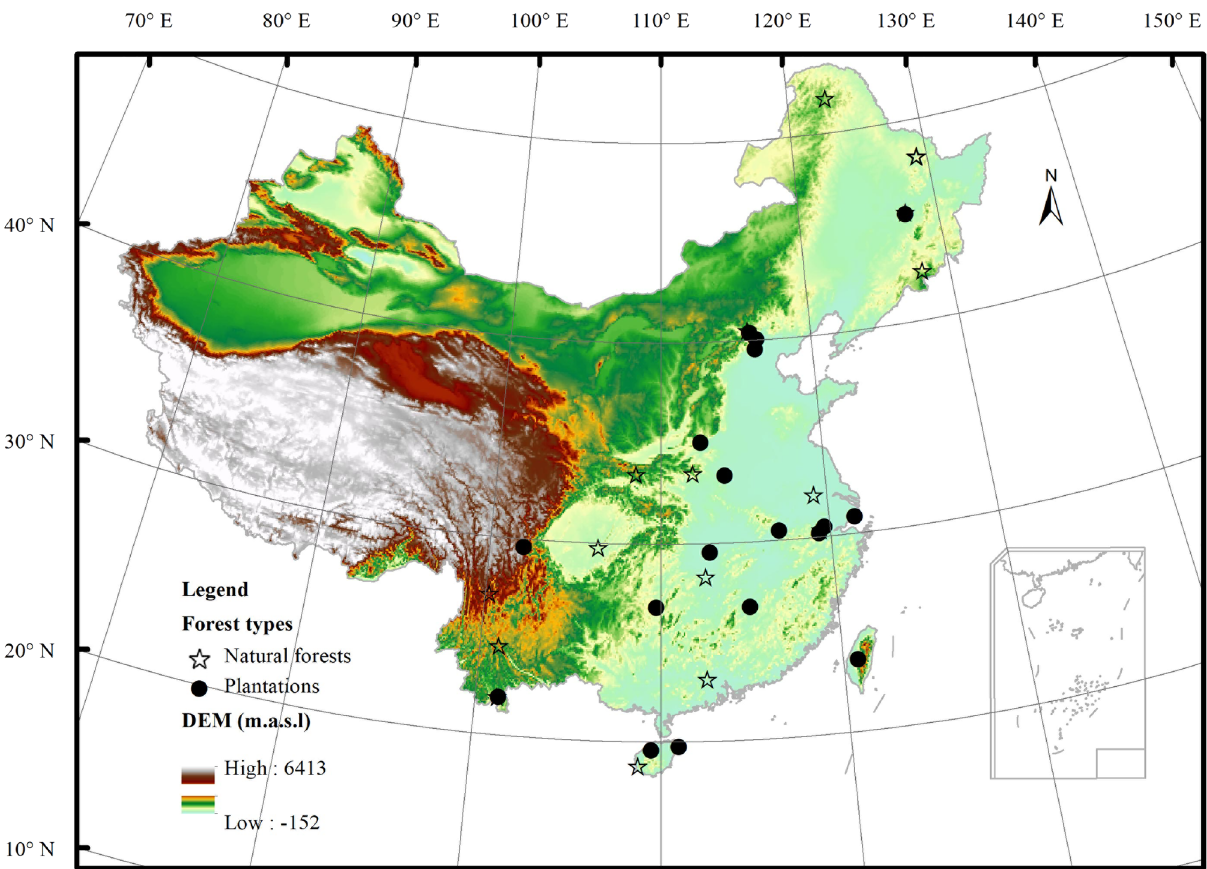
Figure 6. The spatial distribution of ecosystems used in this study. The maps are made by ArcGIS 10.0 software (http:// www. esri. com/ softw are/